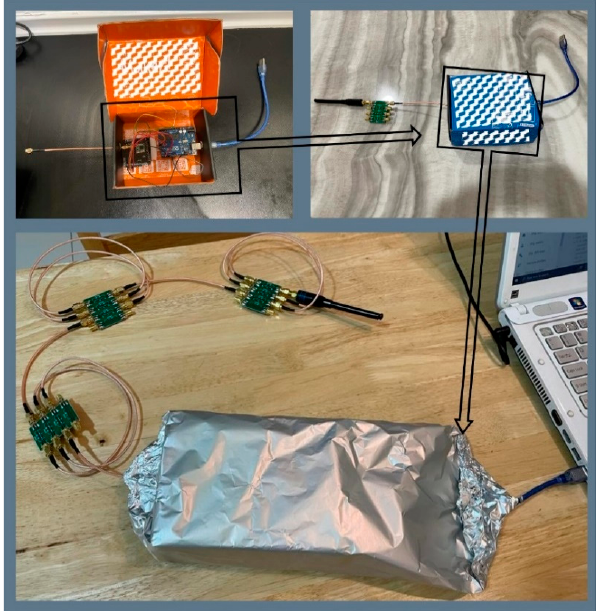
Figure 8. Shielded box to create a Faraday cage-like environment to overcome signal leakage.